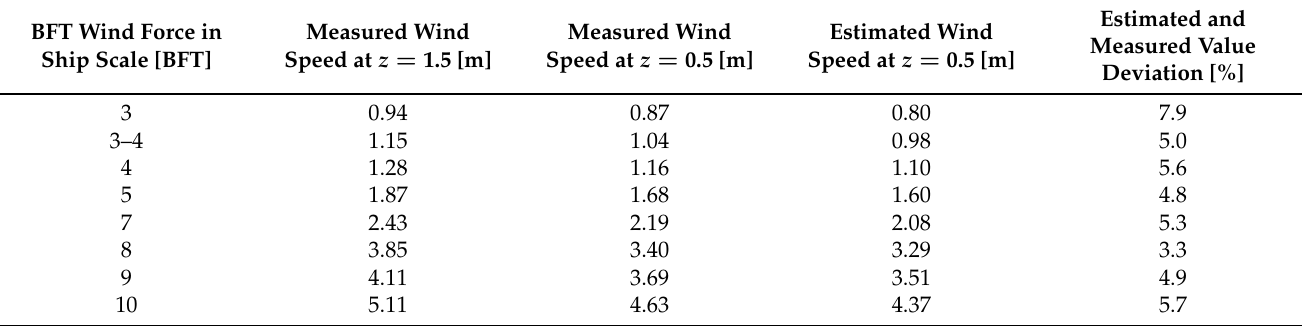
Table 2. Verification of the wind profile